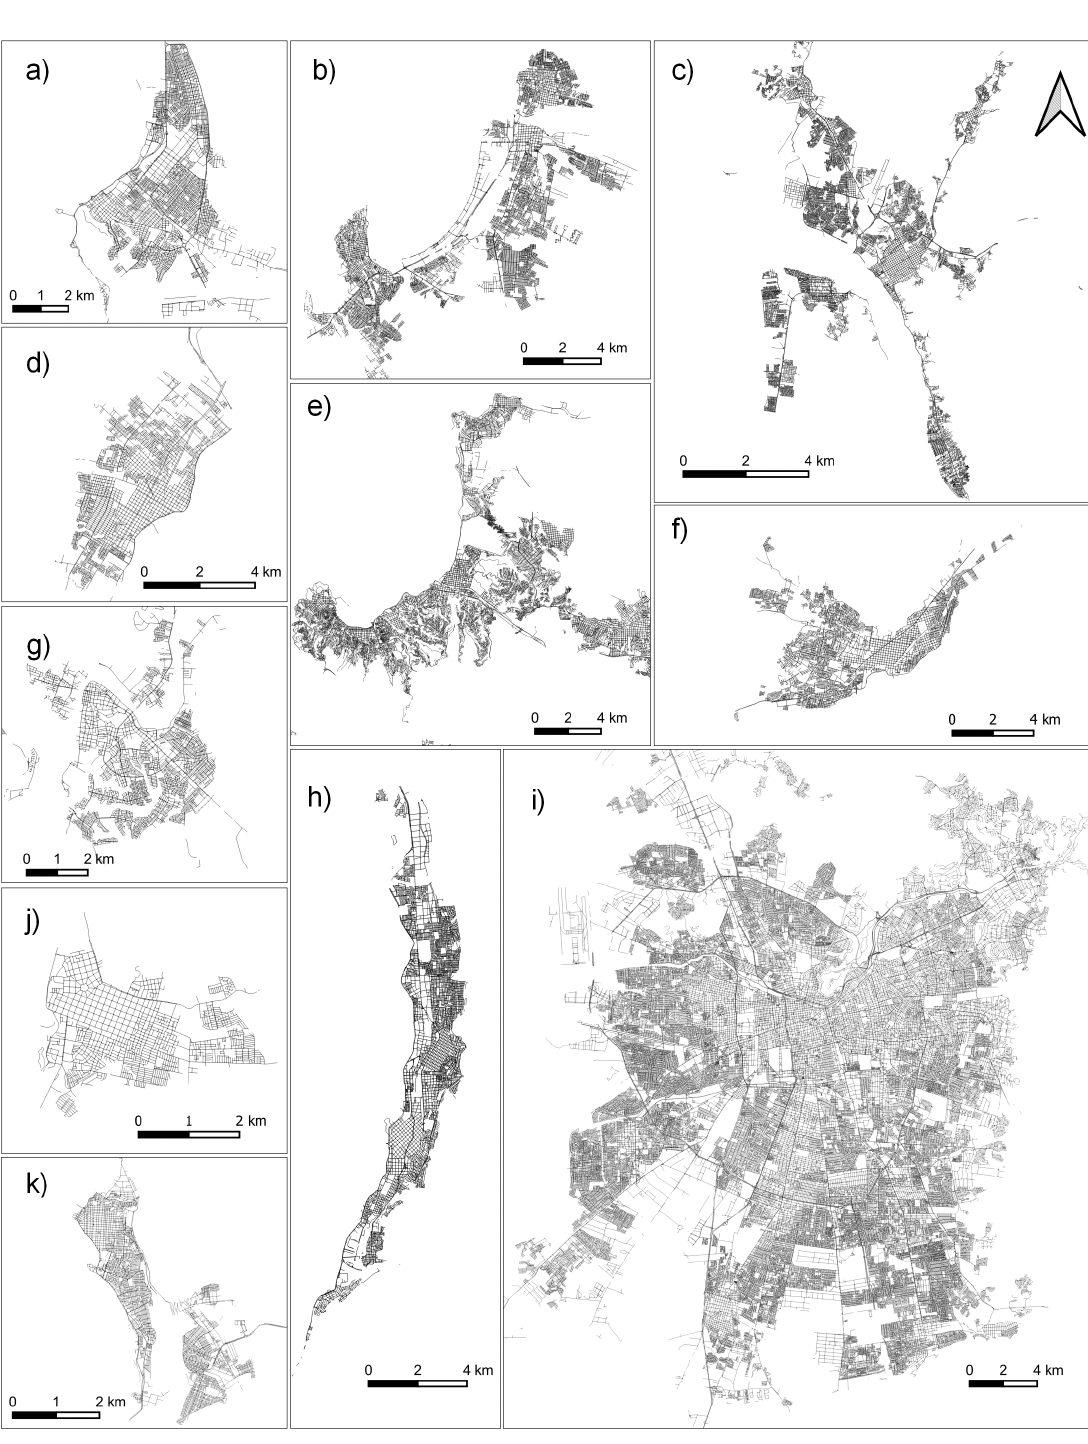
Figure 6. Network patterns of Chilean cities. ( a ) Arica, ( b ) La Serena, ( c ) Concepción, ( d ) Punta Are- nas, ( e ) Valparaíso, ( f ) Temuco, ( g ) Valdivia, ( h ) Antofagasta, ( i ) Santiago, ( j ) Coyhaique, ( k ) Iquique. The map scale is E =